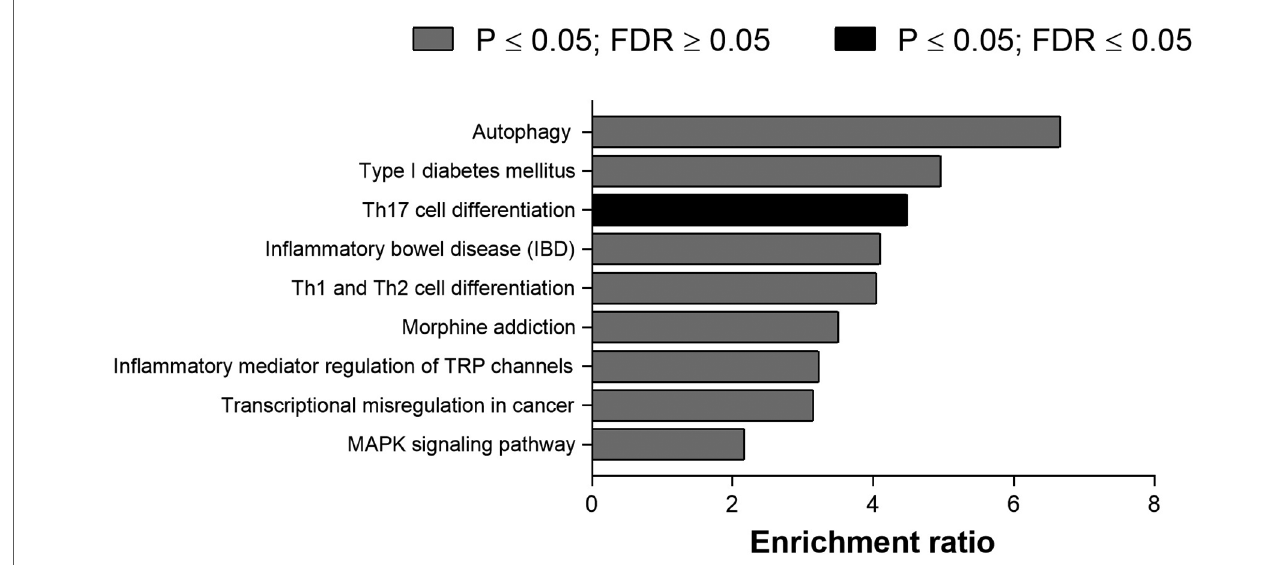
FIGURE 2 Top 10 canonical pathways of differentially methylated CpG sites after physical intervention in bariatric surgery women.